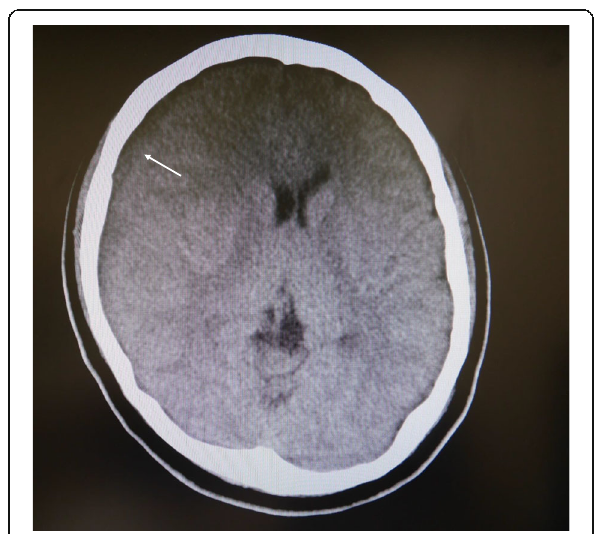
Fig. 2 1 week after epidural blood patch was performed, computed tomogram shows resolution of the subdural hematoma ( arrow